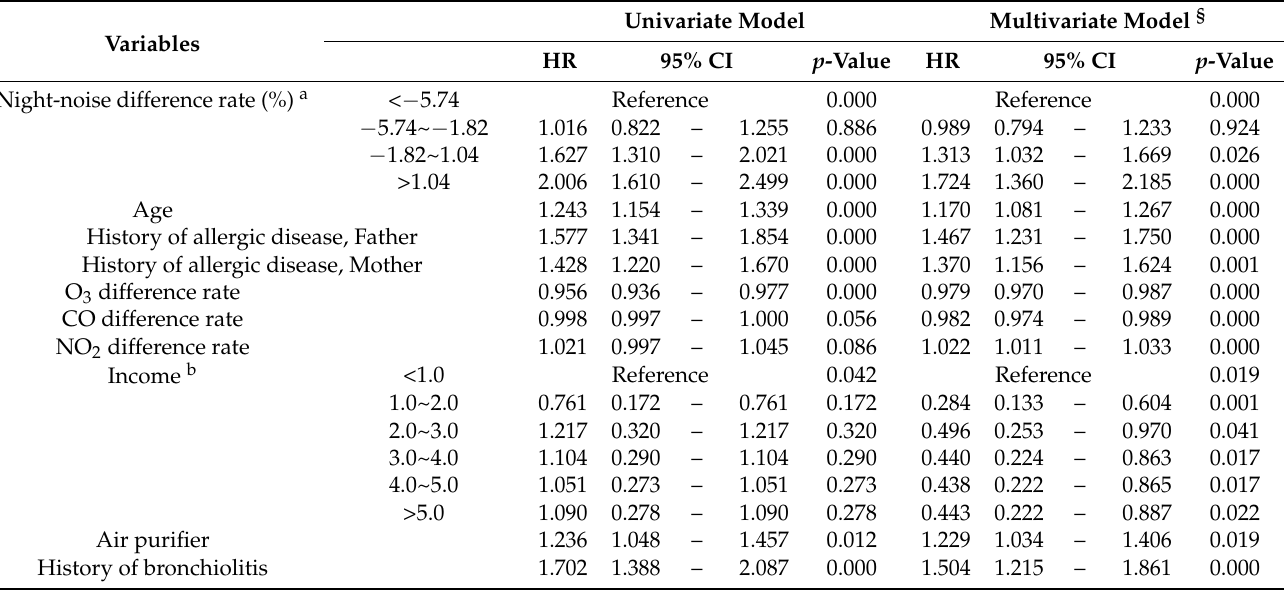
Table 5. Association between night-noise difference and incidence of allergic